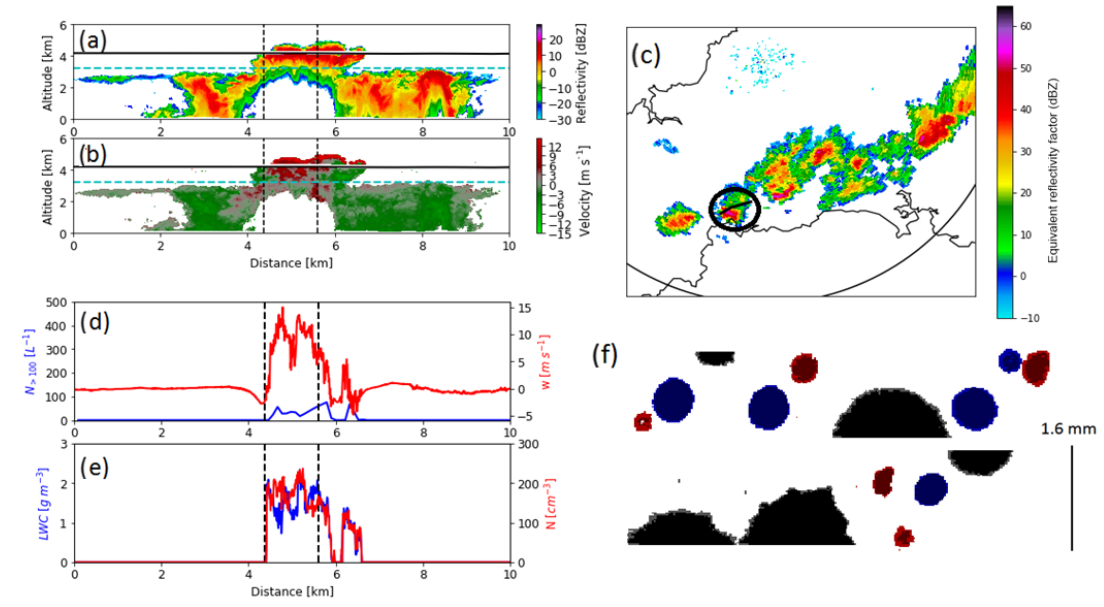
Figure 7. As Fig. 6, but for the penetration at − 8 ◦ with mixed phase precipitation during Case